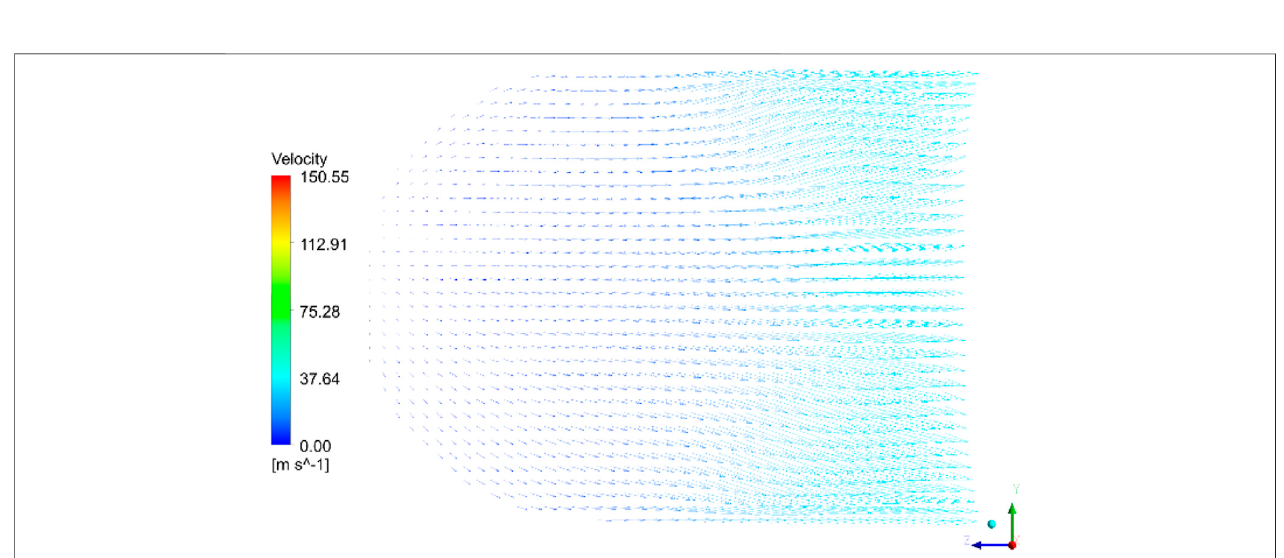
FIGURE 10 | Velocity vector fi eld of the vertical section at the top of the drying tower.